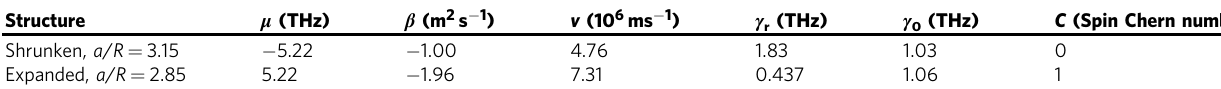
Table 1 Parameters of the effective Hamiltonian extracted by fi tting the experimental data Structure μ (THz) β (m 2 s − 1 ) v (10 6 ms − 1 ) γ r (THz) γ 0 (THz) C (Spin Chern number) Shrunken, a / R = 3.15